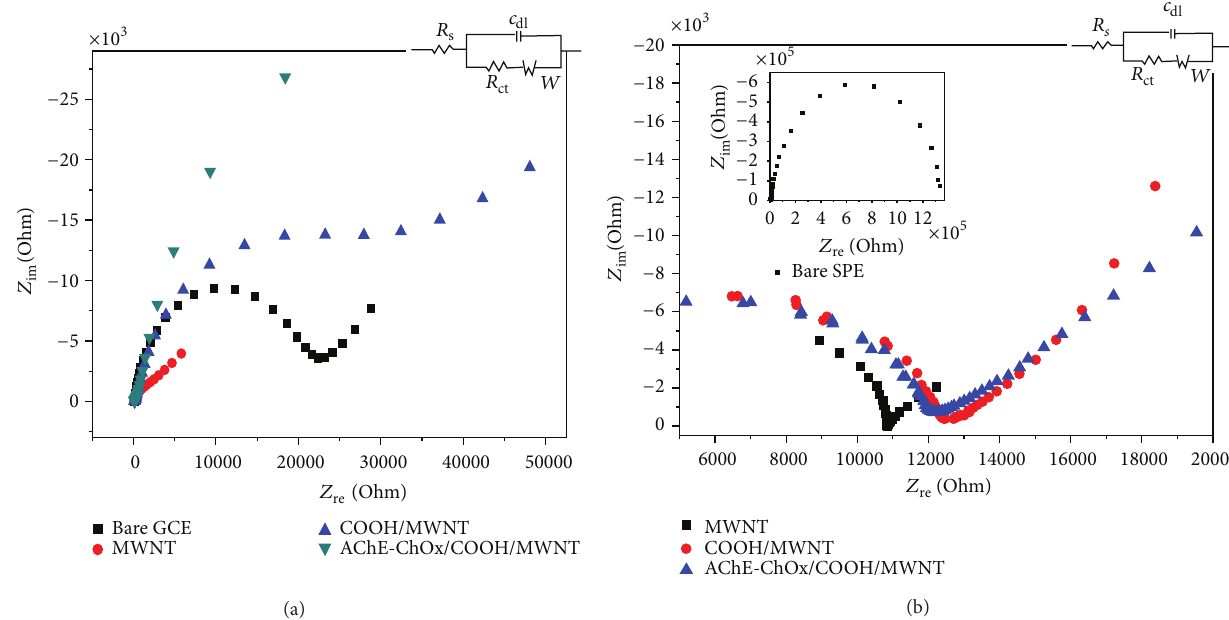
Figure 9: Electrochemical impedance spectra of the AChE-ChOx-modified biosensor based on a GCE (a) and SPE (b) in 0.1M PBS buffer (pH = 7.0) containing 1.0 mM K 3 Fe(CN) 6 /K 4 Fe(CN) 6 .